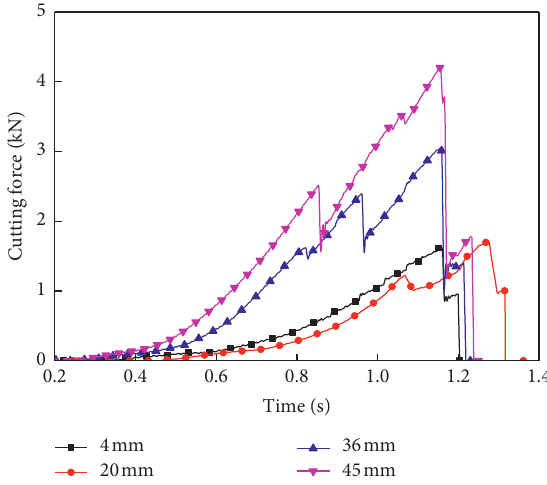
Figure 24: Variation in cutting force with time at different cutting depth.